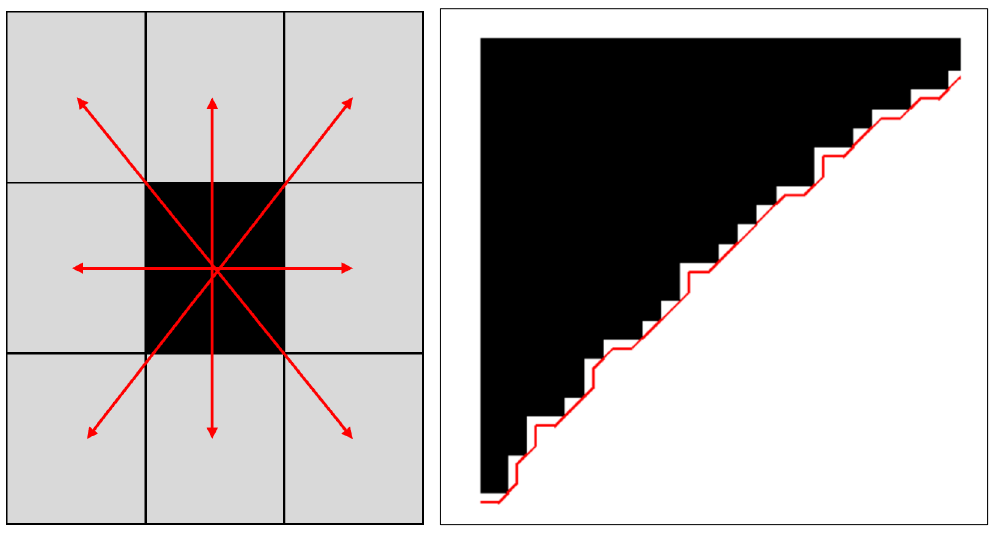
Figure 15. The contour tracing method.